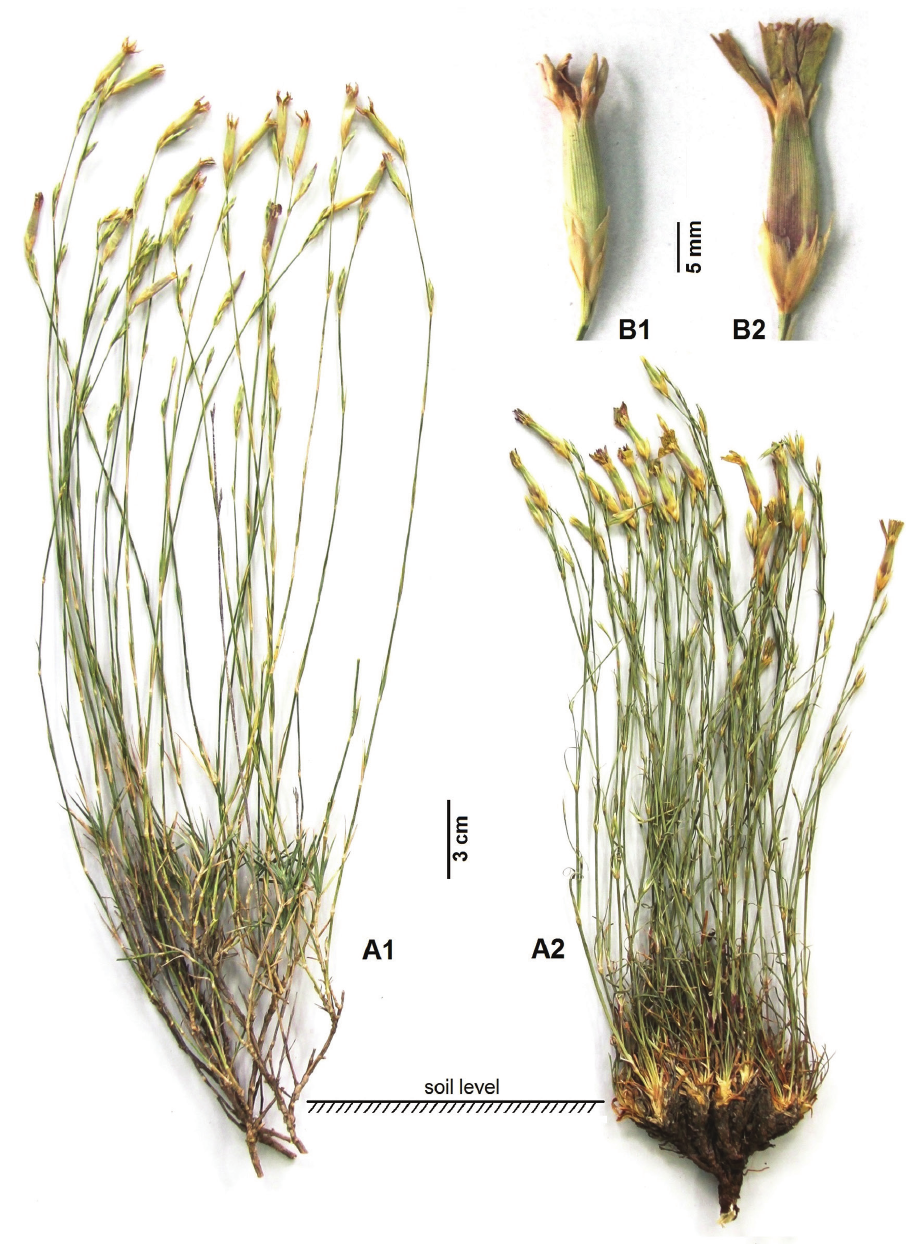
Figure 1. Photographs of plant habit and flowers of D. aticii and D. zonatus . Dianthus aticii – A1 Habit B1 Flower; D. zonatus – A2 Habit B2